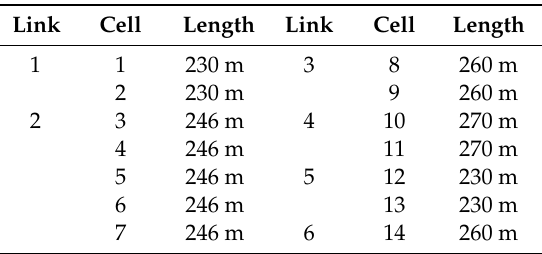
Table 1. Results of cell partition.